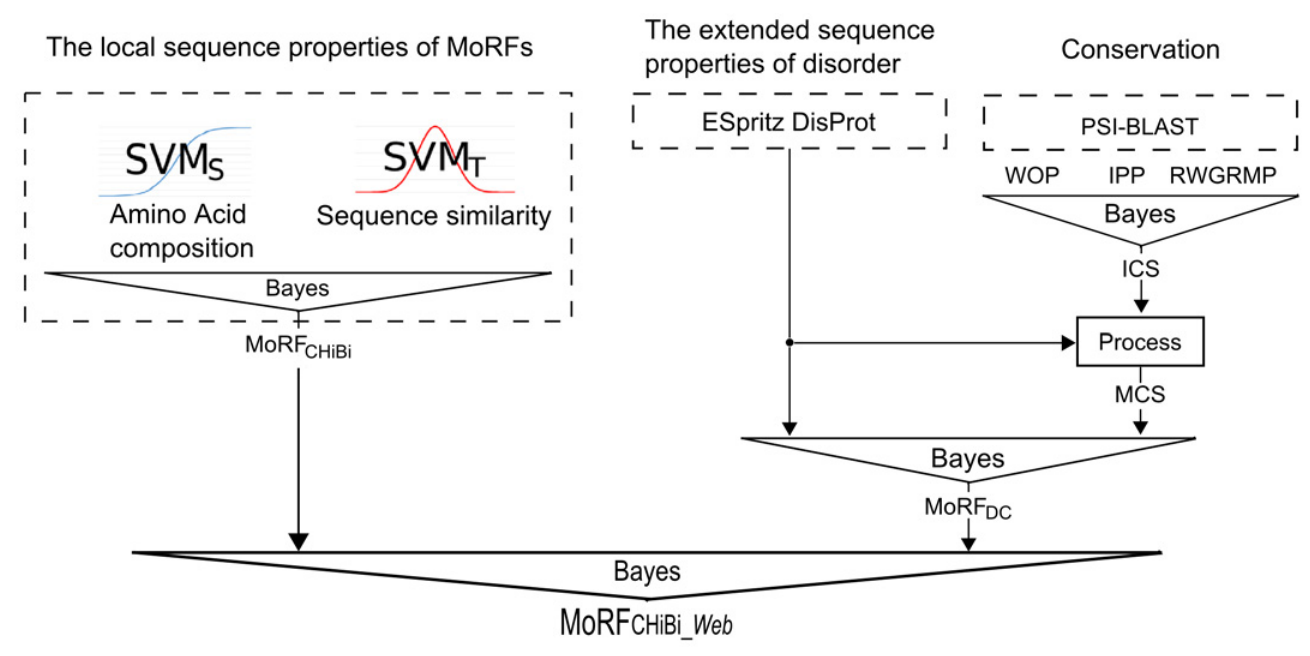
Fig 1. MoRF CHiBi_Web structure. The three components used by MoRF CHiBi_Web are MoRF CHiBi predictions, predictions of disorder by ESpritz with the DisProt option, and conservation predictions using PSI-BLAST. These three components are combined by using Bayes rules at multiple